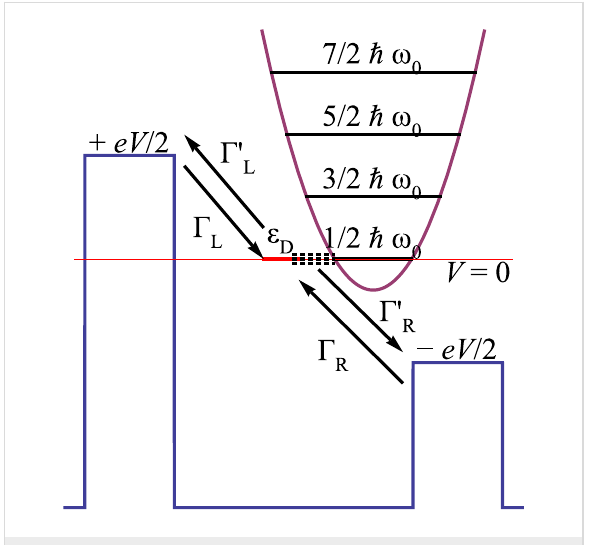
Figure 1: Single charge transfer through a molecular contact consisting of a single electronic level coupled to a harmonic phonon mode and contacted to metallic leads. Forward (no prime) and back- ward (with prime) rates are the basic ingredients for the approximate treatment, see text for